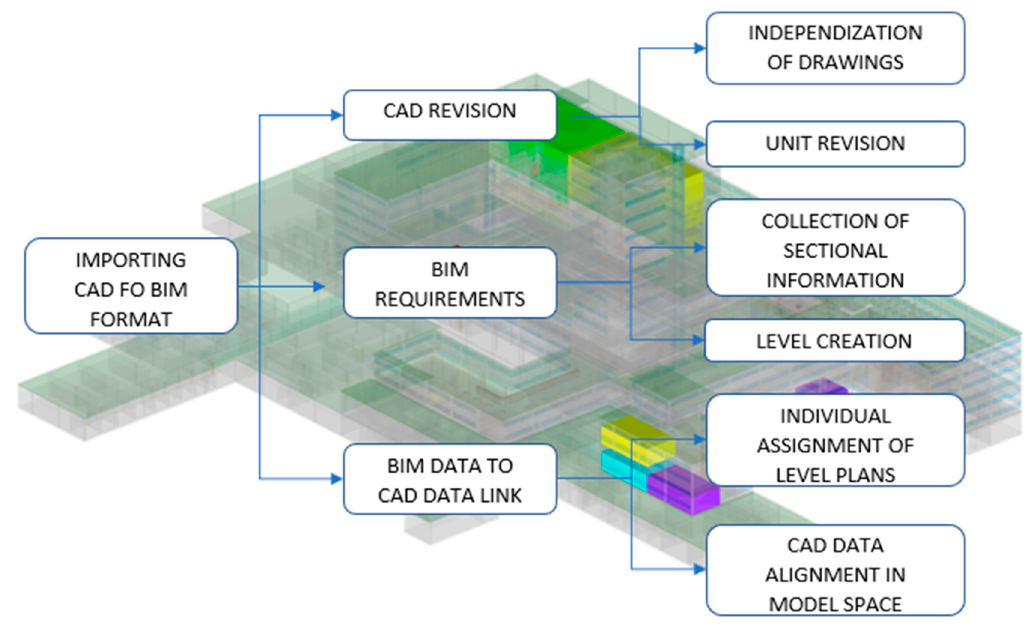
Figure 3. Flow Figure 3. Flow chart.